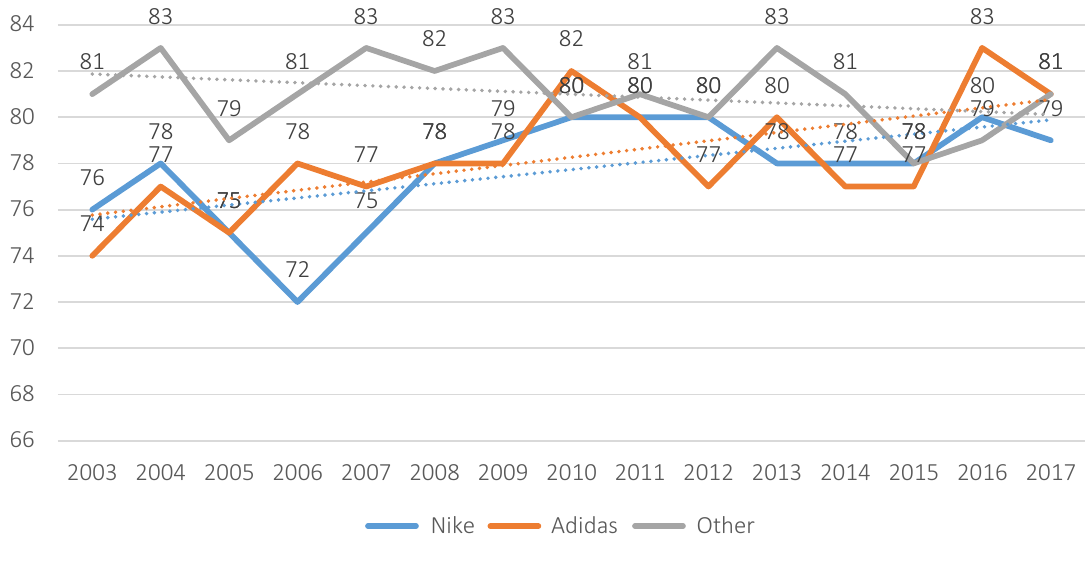
Figure 3. The index of satisfaction of American